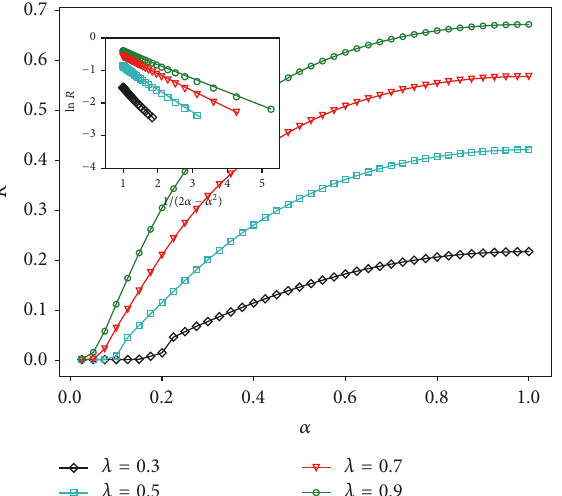
Figure 4: Final rumor size 𝑅 , as a function of activity rate 𝛼 varying over different 𝜆 . Insets show the exponential correlation of 𝑅 and 1/(2𝛼 − 𝛼 2 ) when 𝜆 is greater than critical 𝜆 𝑐